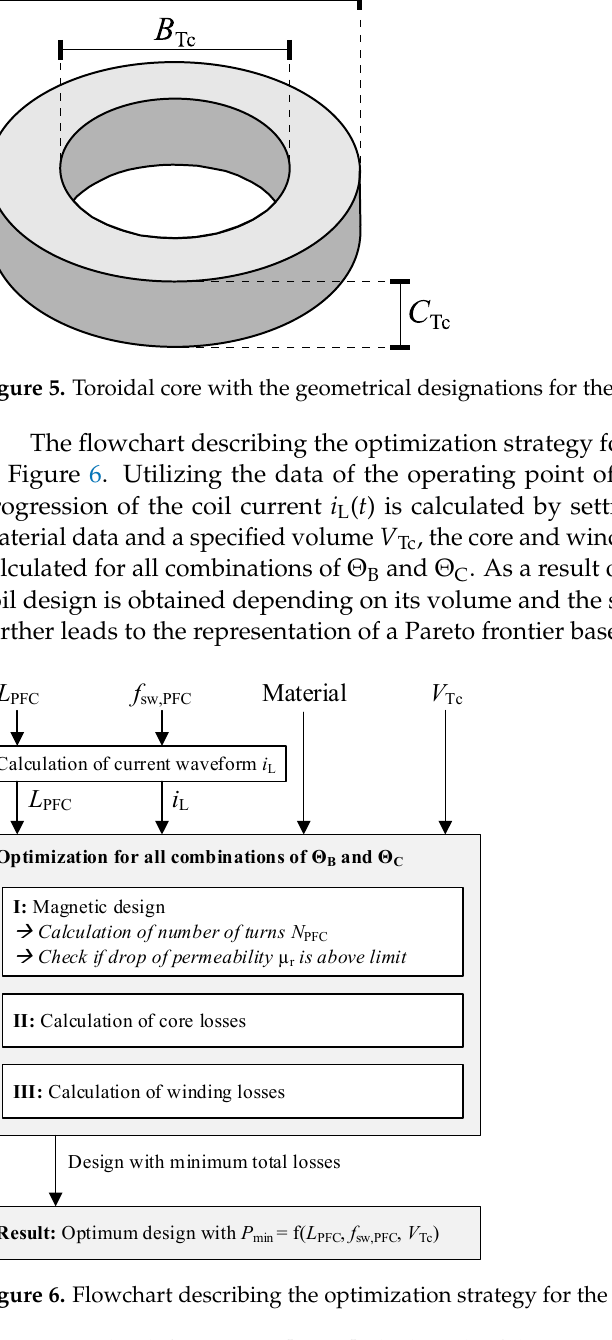
To optimize the geometry of the toroidal core without changing the volume of the component, the ratios